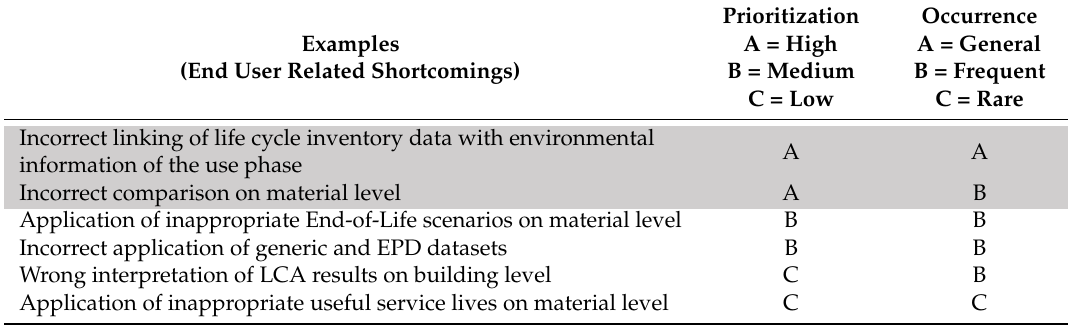
Table 2. End user related shortcoming–Examples and their prioritization for solution-oriented